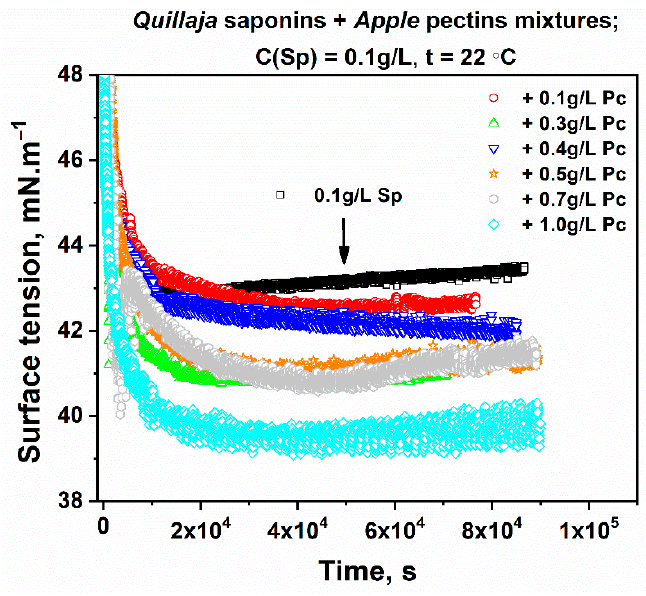
Figure 2. Dynamic surface tension of Quillaja saponin and Apple pectin mixture solutions at a constant saponin concentration (C(Sp) = 0.1 g/L) and various pectin quantities.